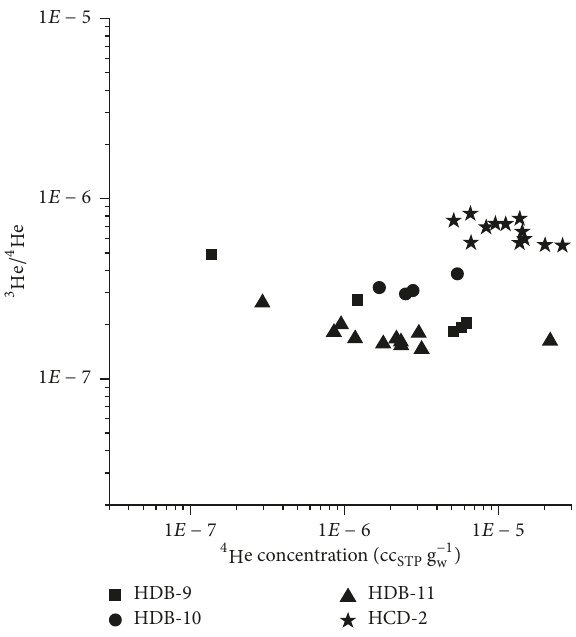
Figure 5: Depth profile of 4 He concentration in the Koetoi and Wakkanai formations plots with open circle: significant amounts of bubbles were observed on the surface of the core during the sampling procedure.